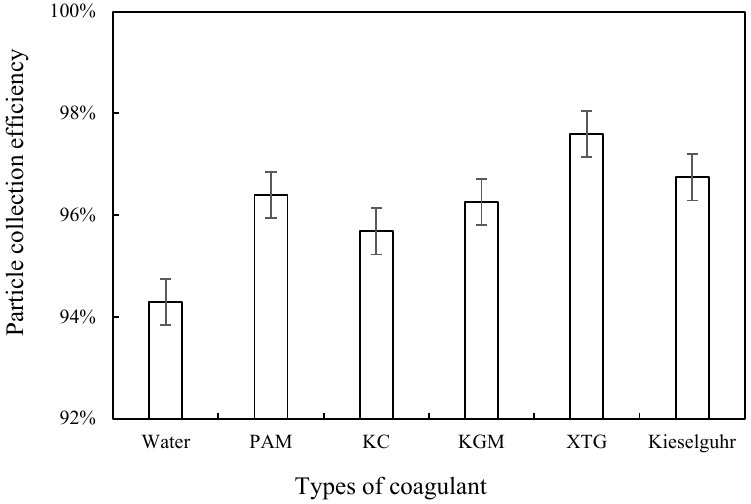
Figure 6. Effect of coagulant type on dust removal efficiency.